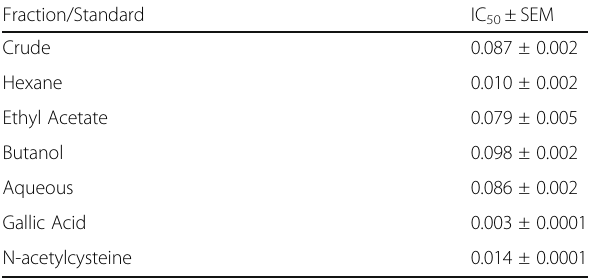
Values are expressed as mean±SEM, p <0.001